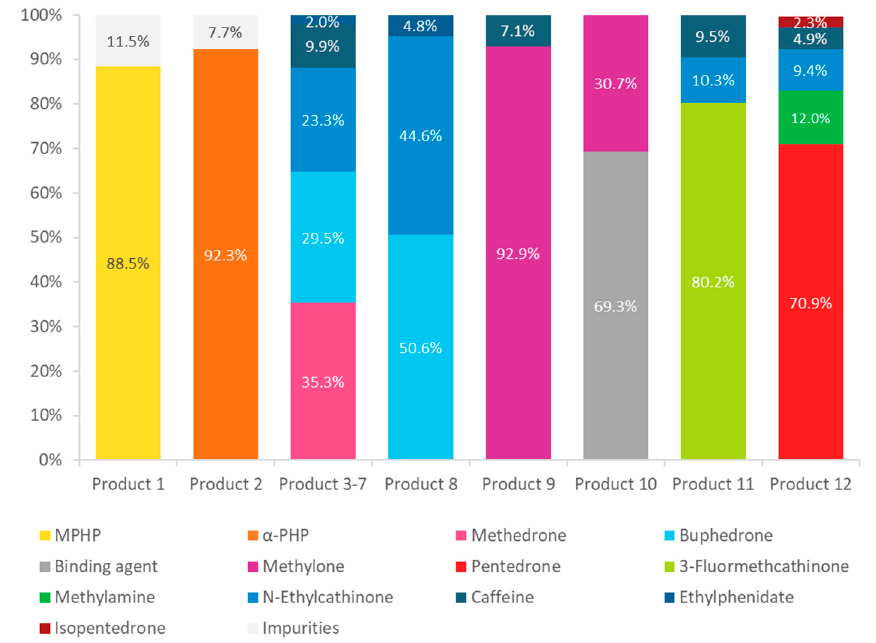
Figure 9. Relative proportions of active substances detected in 12 seized products.